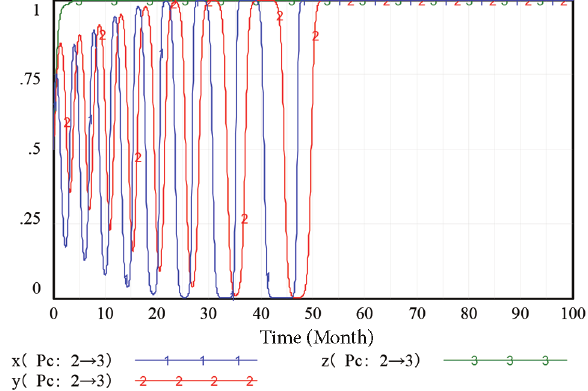
Figure 10. Game results under reward increase for CSE ( R c )